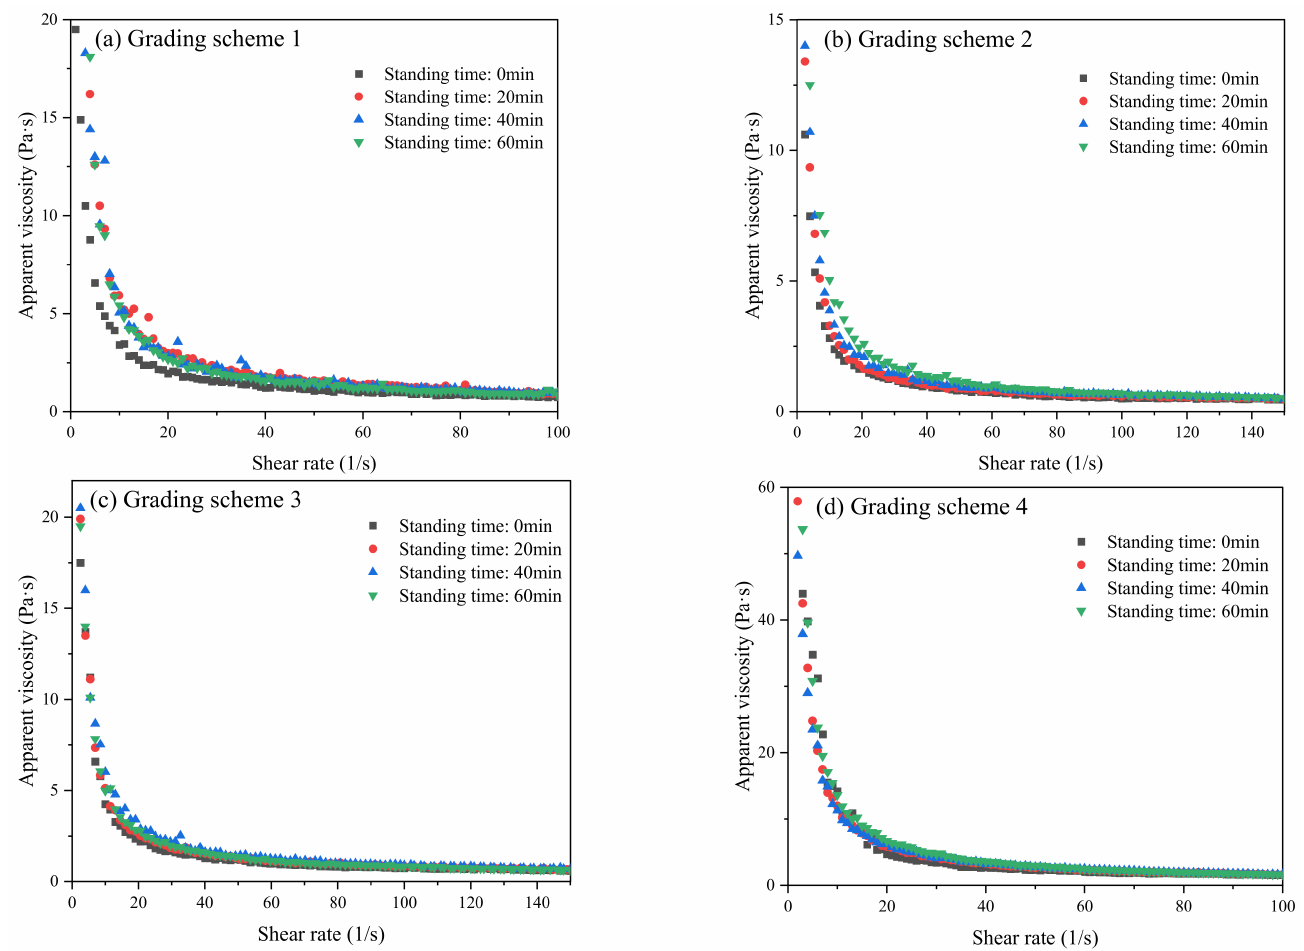
Figure 10. Apparent viscosity & shear rate curve in different grading schemes at 70% mass fraction.